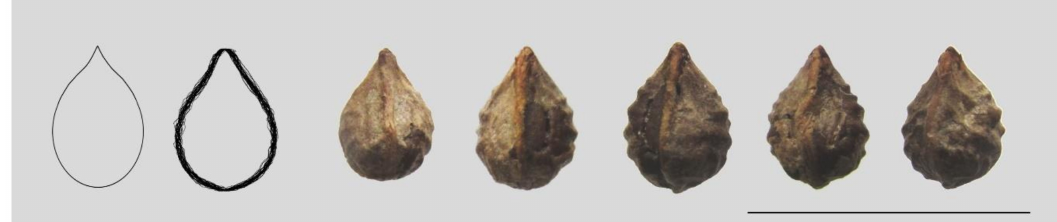
Figure 7. From left to right: Model 4 (an elongated water drop), a figure composed with the silhouettes of 20 seed images, and five representative images of seeds of C. verticillata . The bar is equal to 1 cm.